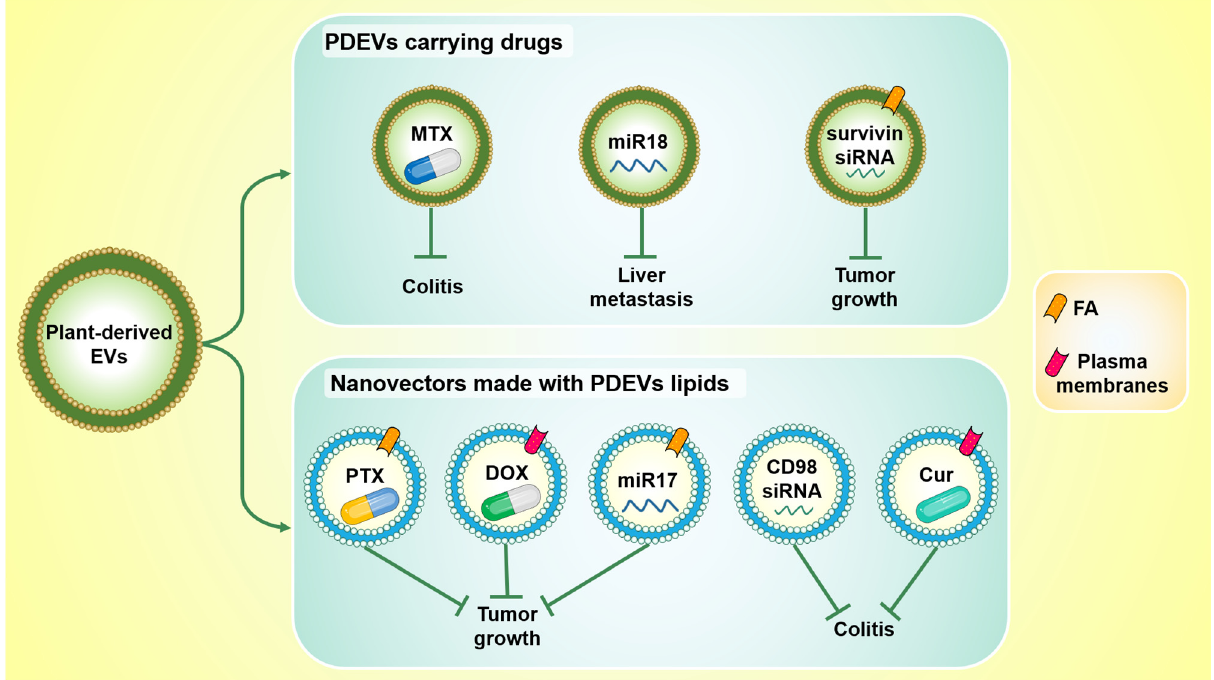
Figure 3. Plant-derived EVs and nanovectors made with their lipids represent promising drug delivery systems. PDEVs can be loaded with both drugs and oligonucleotides ( top ): PDEVs carrying methotrexate (MTX) counteract ulcerative colitis in vivo; PDEVs carrying miR18 reduce liver metastasis in vivo; PDEVs conjugated with folic acid (FA), and loaded with survivin siRNA, inhibit tumor growth. Nanovectors derived from PDEVs lipids have also been shown to be useful as drug delivery vehicles ( bottom ): they inhibit tumor growth when they carry Pentoxifylline (PTX) or miR17 and are conjugated to FA, as well as when they carry doxorubicin (DOX) and are conjugated with inflammatory chemokine receptor enriched membrane fraction (plasma membranes). Moreover, they are also able to counteract ulcerative colitis when they deliver CD98 siRNA or curcumin (Cur) and are conjugated with plasma membranes.